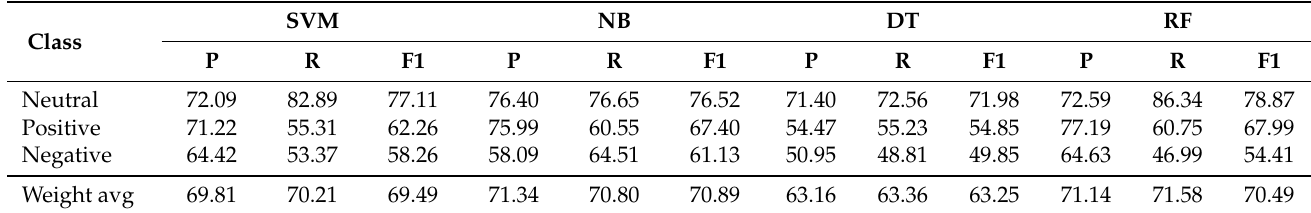
Table 10. Performance of CML models using tf representations.